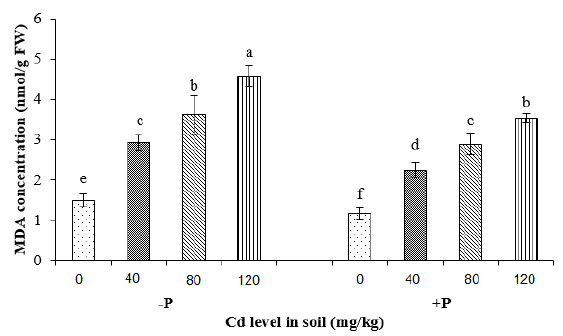
Fig. 5. The effect of P. indica on leaf MDA concentration in sunflower under different Cd concentrations in soil. P: P. indica. Values are mean ± SD; n = 5. The same letter within each column indicates no significant difference among treatments using Duncan’s Multiple Range Test at P <